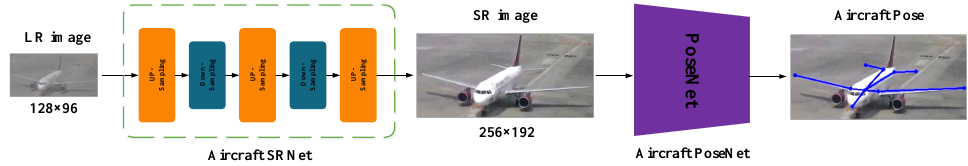
Figure 3. Low-resolution aircraft pose estimation pipline.